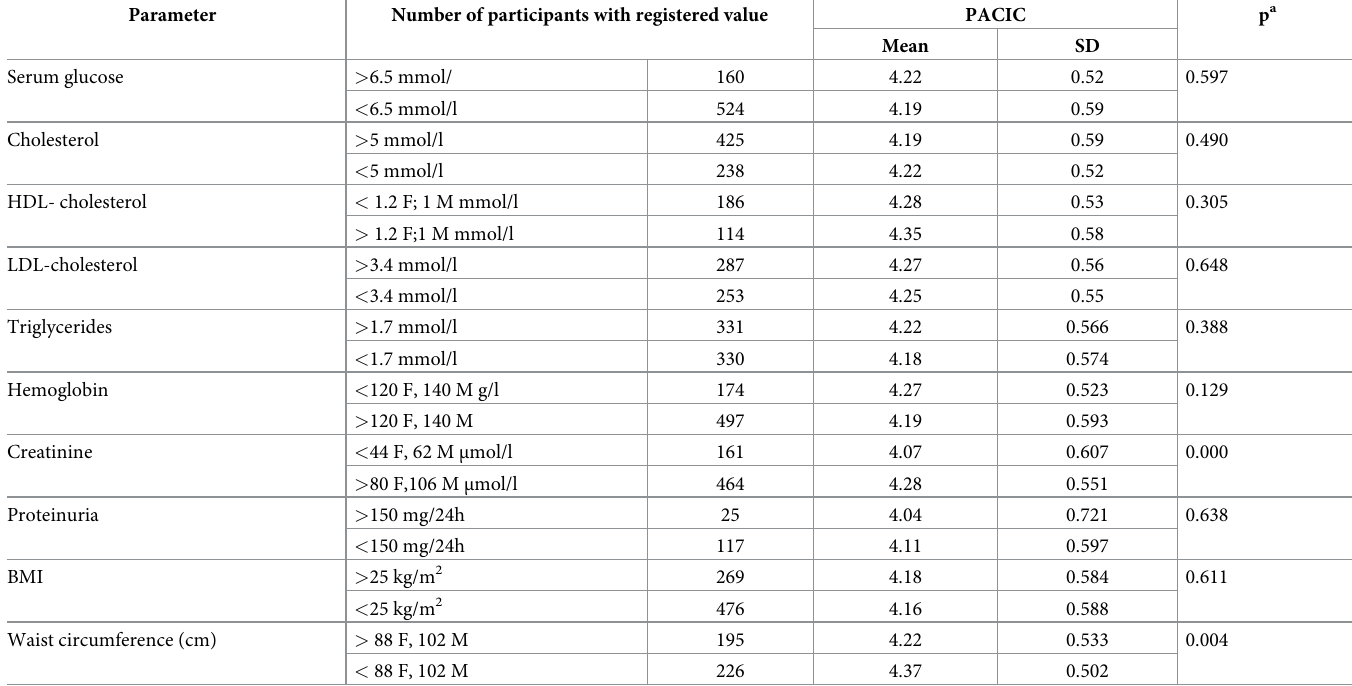
Table 4. Differences in PACIC scores according to the values of clinical parameters.